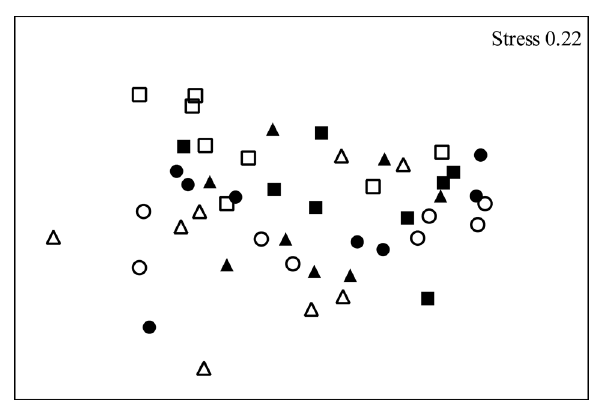
Fig. 4. Multi-dimensional scaling evaluating the effect of Manila clams and anti-predator netting status on benthic assemblage structure (n = 8). Treatments are combinations of presence (filled symbols) or absence (open symbols) of Manila clams Venerupis philippinarum and anti-predator net status (squares: fouled; triangles: cleaned; circles: without)